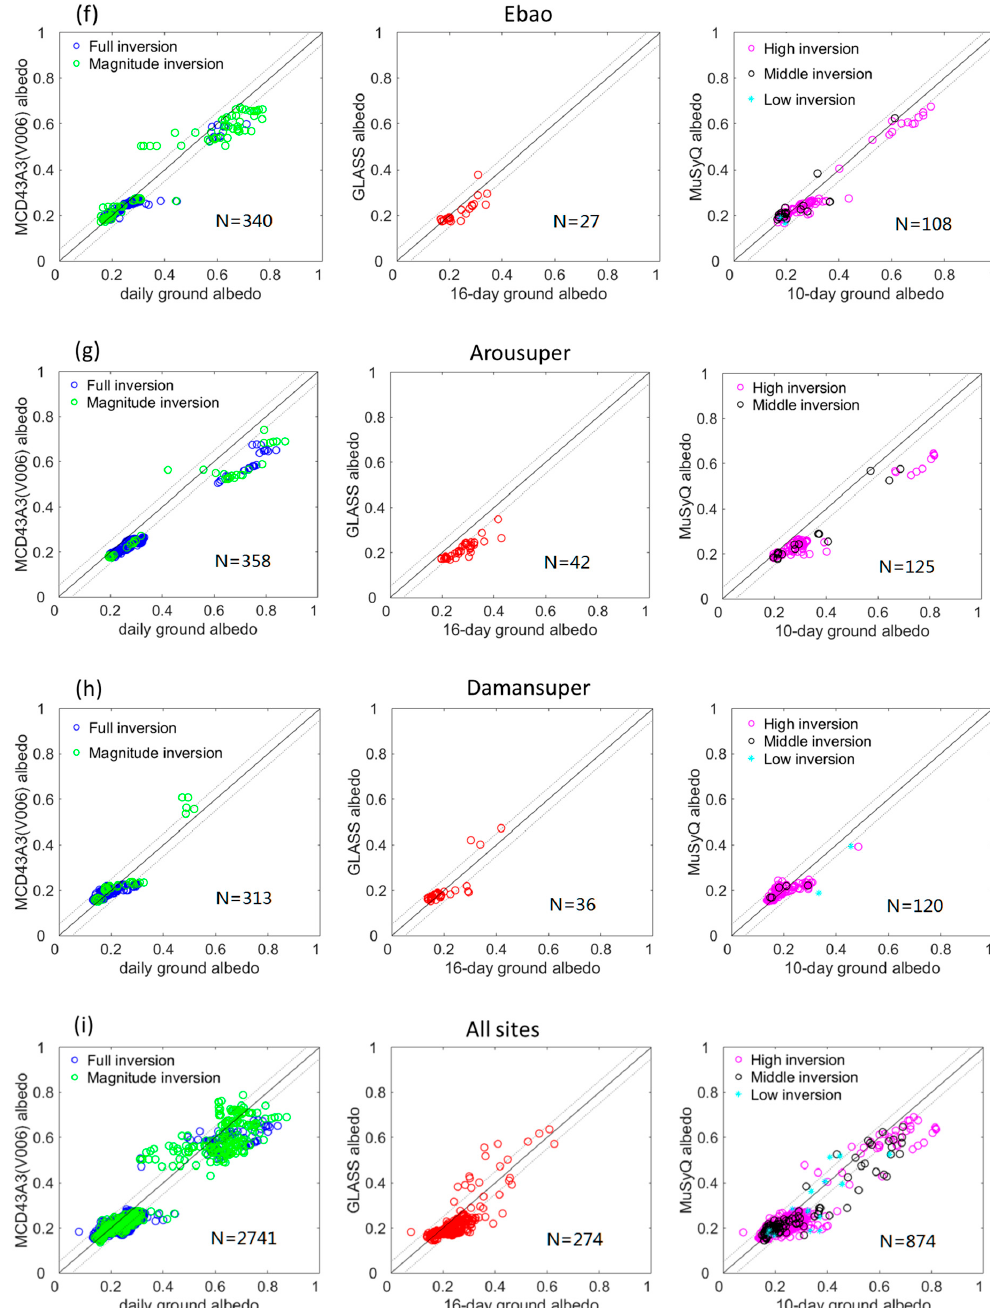
Figure A2. (a–i) The direct comparison results for MCD43A3 (V006) (left), GLASS (middle) and MuSyQ (right) albedos. The dotted lines show the errors on the interval [ − 0.05, 0.05]. N indicates the number of the data points.